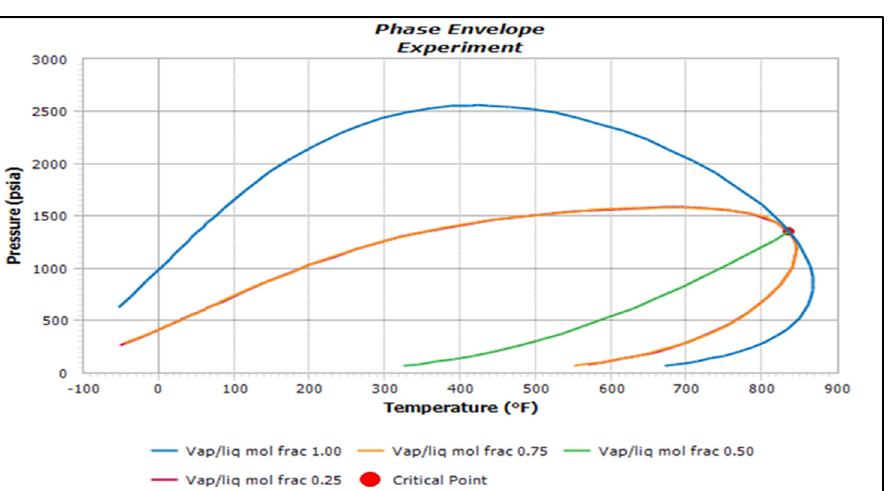
Figure 4. Regressed phase envelope for the 9 component FWU compositional fluid model.